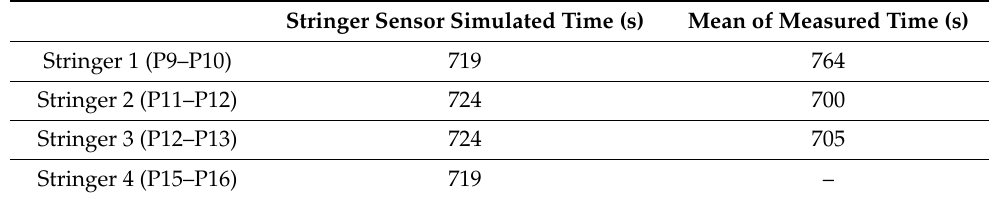
Table 3. Comparison between numerical and experimental